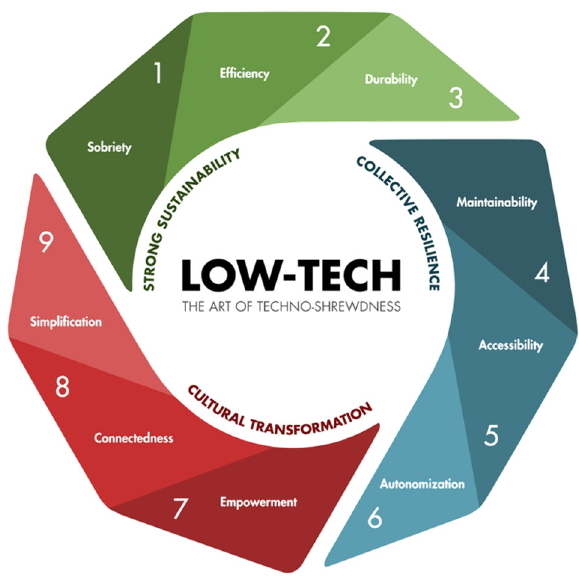
Figure 2. Fundamental principles of low-tech [19].